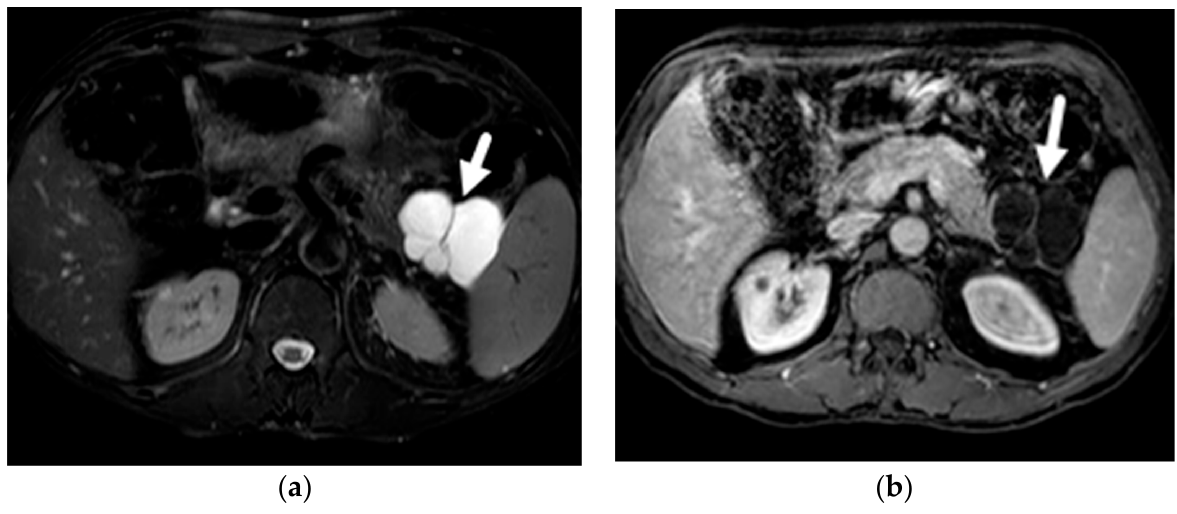
Figure 6. Macrocytic SCA. ( a ) Axial T2-weighted image demonstrates a macrocystic lesion with few septations in the pancreatic tail (arrow). ( b ) T1-weighted post contrast image demonstrates the thin enhancing septa. The lesion represented a SCA on surgical pathology.